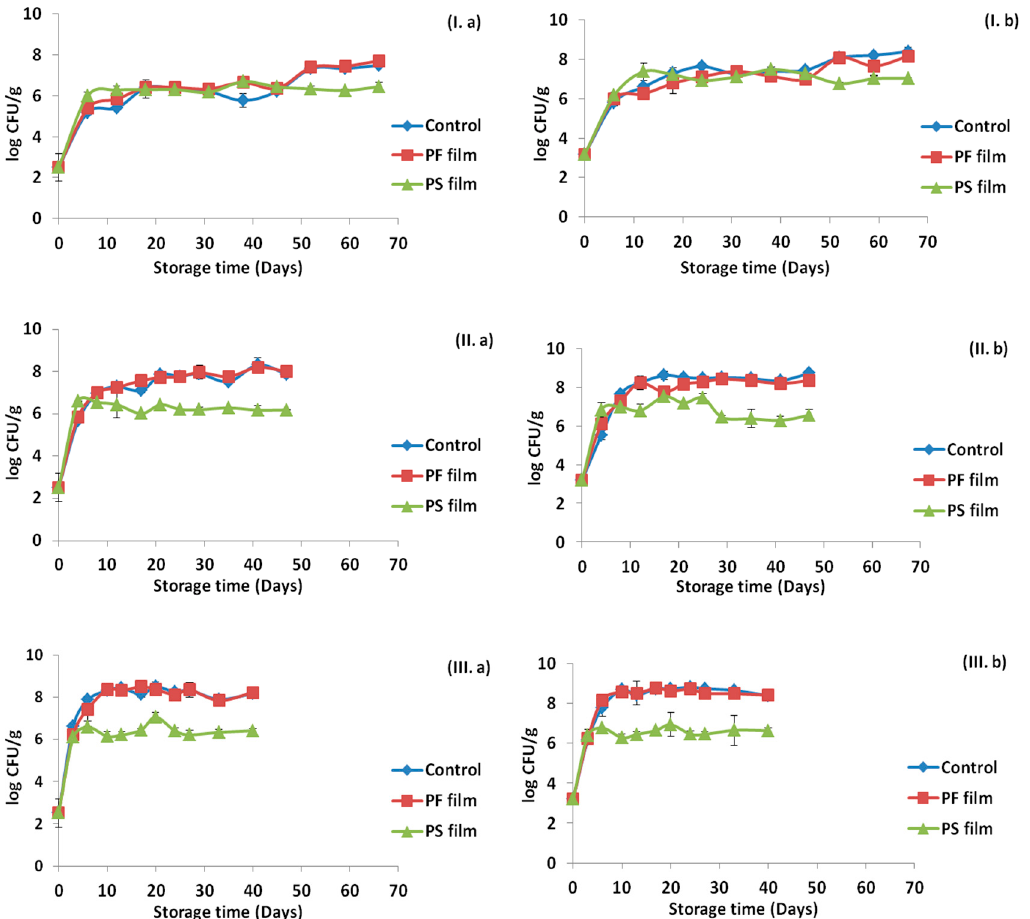
Figure 1. Changes in population levels of: ( a ) lactic acid bacteria; and ( b ) Total Viable Counts in ham slices with probiotic-supplemented edible films (PS) without high pressure processing (HPP) treatment during storage at: 4 °C ( I ); 8 °C ( II ); and 12 °C ( III ). Samples without edible films (controls) or with probiotic-free edible films (PF) were also studied.